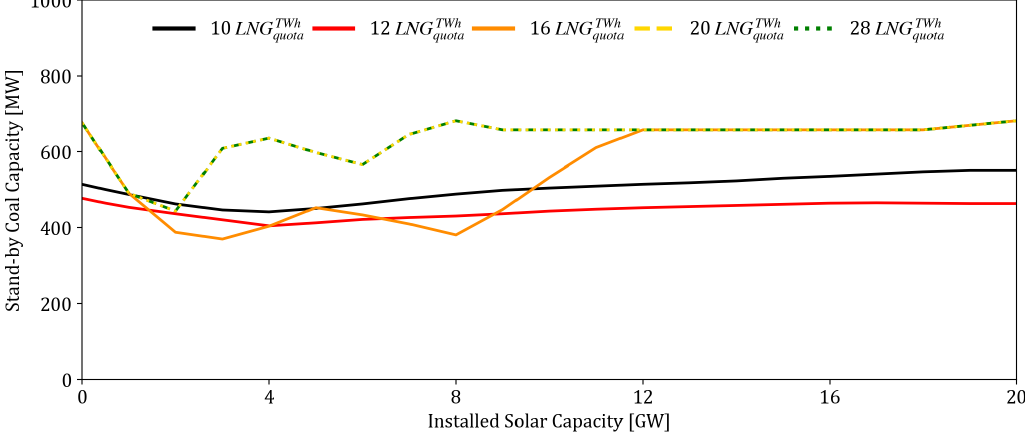
Figure 12. Standby coal capacity needed to ensure that the electricity grid can still handle weather-driven demand